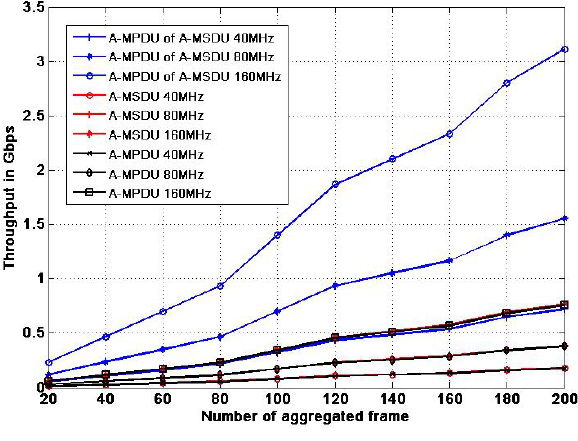
Figure 6. Throughput for the basic access scheme